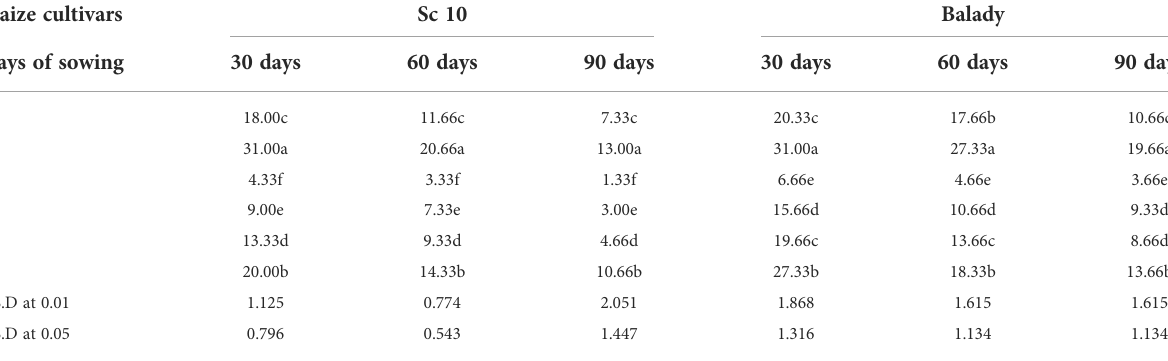
TABLE 5 Fusarium verticillioides frequency % from roots under different soil treatments at different times after sowing during the 2021 growing season. Maize cultivars